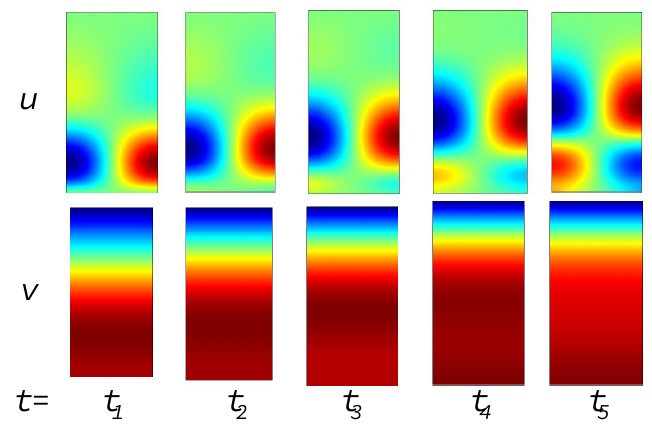
Figure 7. Propagation of Finite Element Modeled (FEM) u and v wave-like pattern. Stage 2 (2.86% < (cid:101) xx <